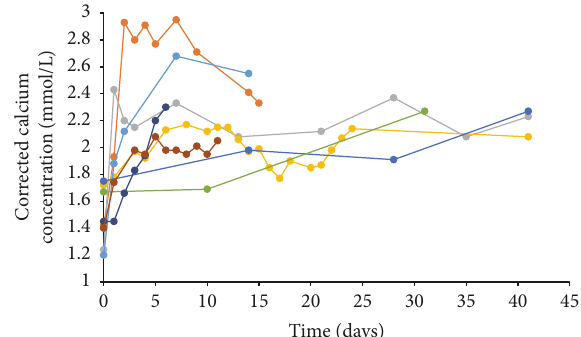
Figure 1: Corrected calcium levels on admission day (time 0) and subsequently (n=8